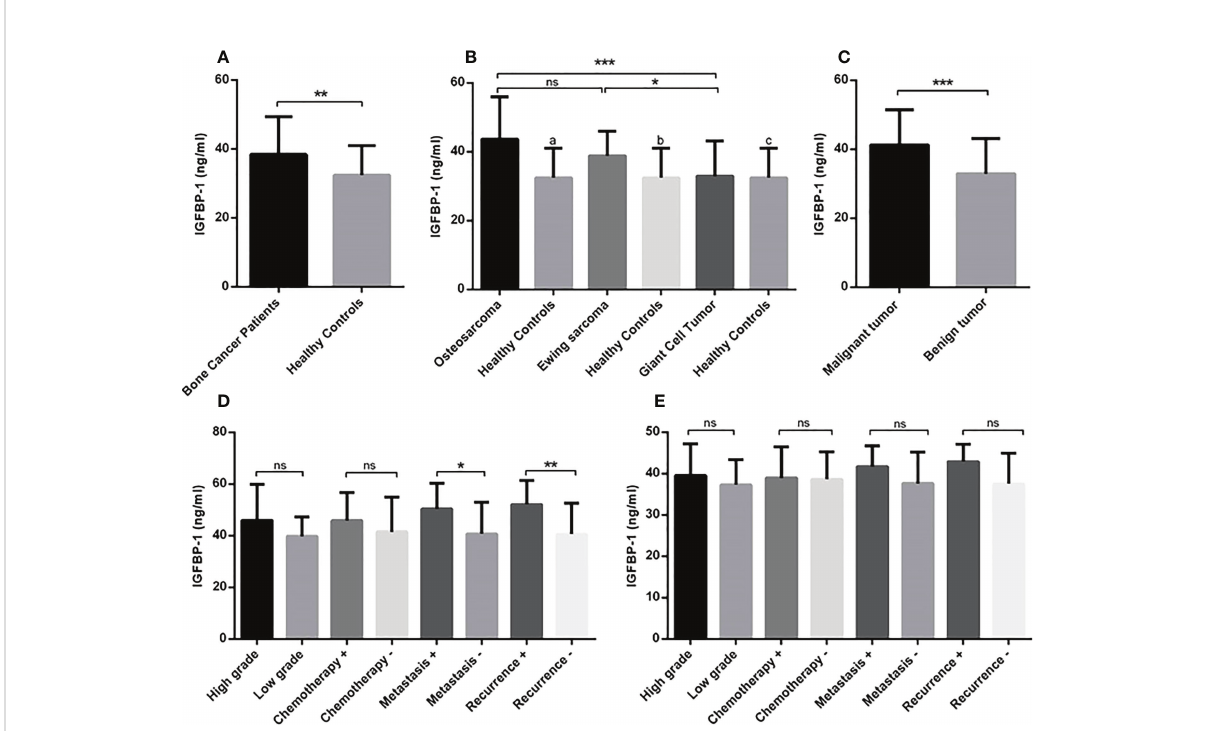
FIGURE 5 The IGFBP-1 level in patients with primary bone tumors. The IGFBP-1 level is increased in patients with bone tumors (N=90) versus healthy controls (N=30) (A) , patients with osteosarcoma (N=30) and Ewing sarcoma (N=30) compared to the healthy controls (N=30) and GCT group (N=30) (B) . The patients with malignant tumors (N=60) expressed a higher levels of IGFBP-1 (C) ; while comparing the tumor subtypes, patients with metastatic (N=9) and recurrent (N=8) osteosarcoma tumors showed higher IGFBP-1 level compared to their opposite counterparts (D) and no signi fi cant difference was detected in Ewing sarcoma subtypes (E) . The number of examined samples in each tumor subtype is shown in Supplementary Table 1. The statistical differences between groups are shown as asterisks (*P <0.05, **P <0.01, ***P <0.001), and (ns) indicates unspeci fi c. (a) indicates P=0.0001, (b) indicates P=0.002 and (c) indicated P=0.864 for comparing osteosarcoma, Ewing sarcoma, and GCT with healthy